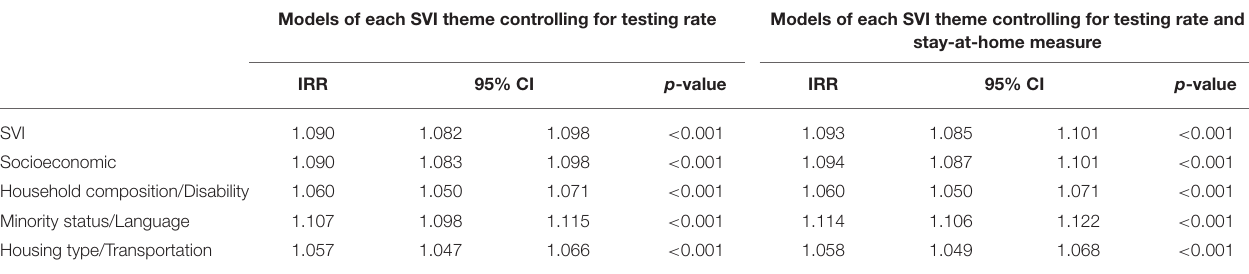
TABLE 3 | The association between social vulnerability and incidence of SARS-CoV-2 after controlling for covariables, Harris County, Texas, May 15 to October, 2020 ( n = 783). Models of each SVI theme controlling for testing rate Models of each SVI theme controlling for testing rate and